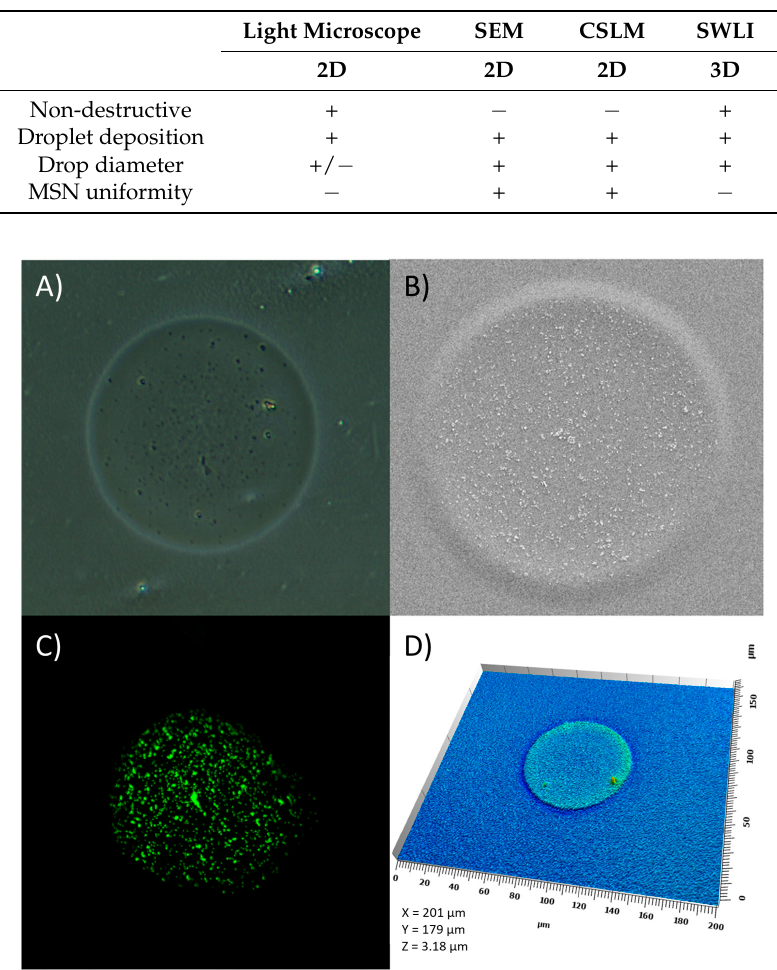
Figure 10. Imaging methods of droplets: ( A ) Light microscope, 1 mg/mL MSN–PEI–F15; ( B )